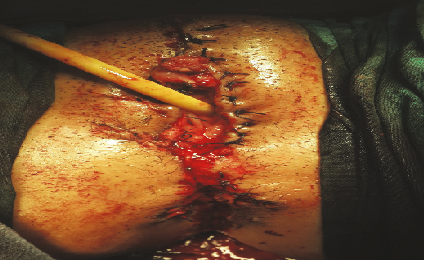
Figure 2: The appearance of Case 1 immediately after surgical resection.